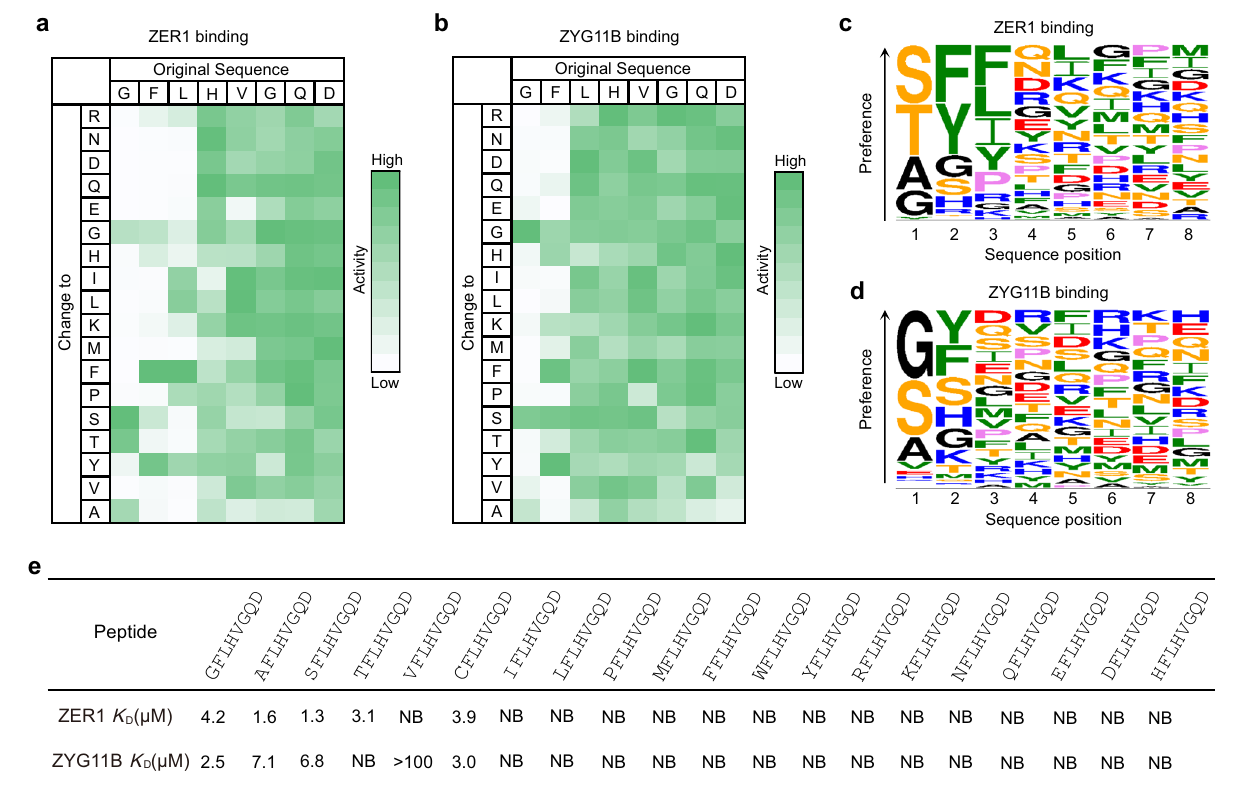
Fig. 1 | ZER1 and ZYG11B can recognize non-glycine small Nt-residues. a , b BindingpatternsofGST-taggedZER1 469 – 766 andZYG11B 490 – 744 topeptideSPOT arrays containing the GFLHVGQDGLELPTS peptide and its indicated derivatives containingmutationsinthe fi rst8positions.Thearraybindingdatawerequanti fi ed and the relative binding of ZER1 and ZYG11B to each peptide isshown, with strong